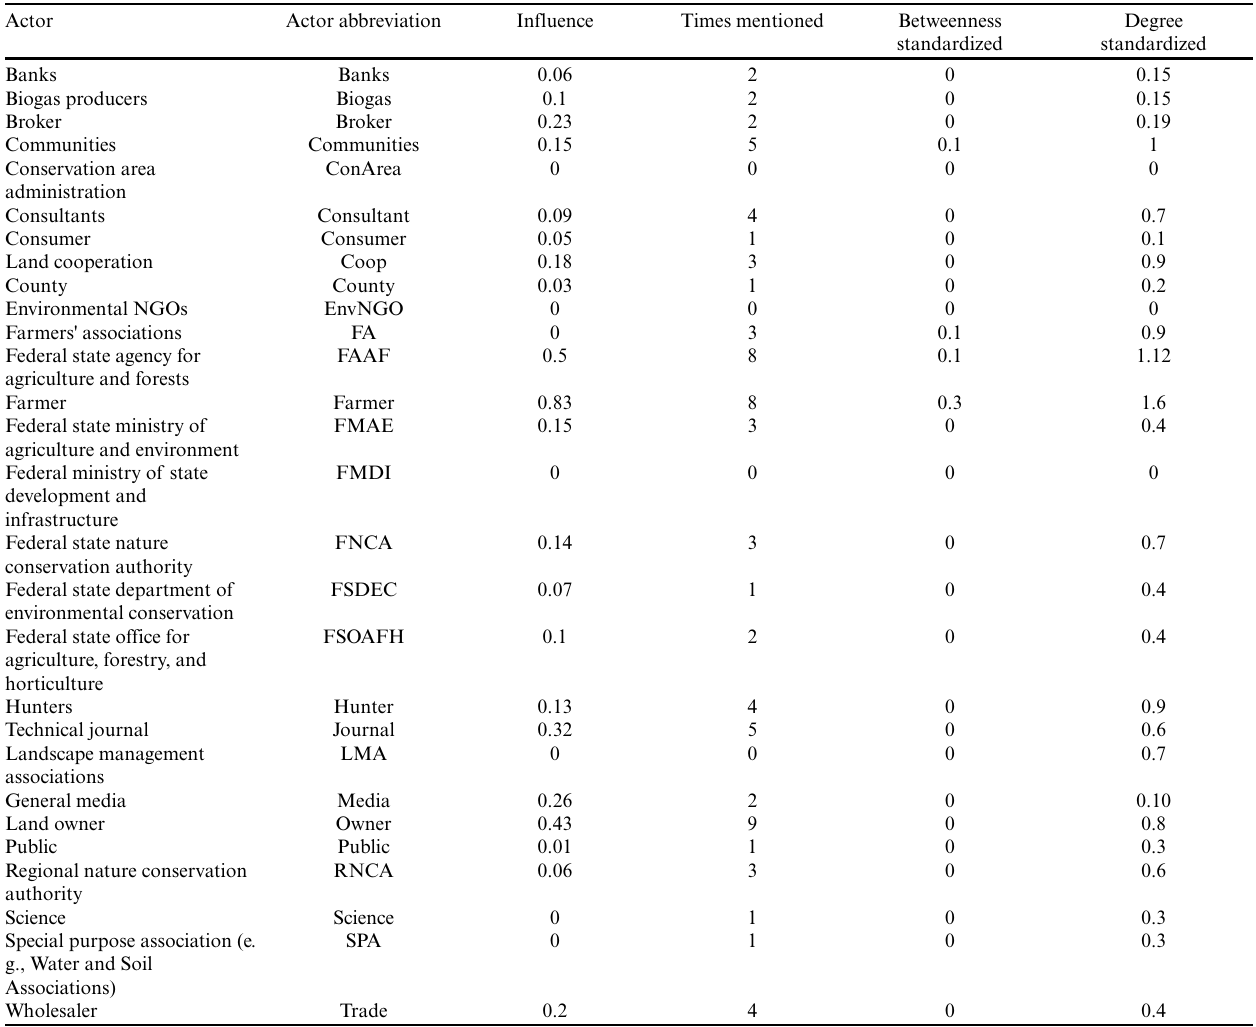
Table 2 . The table presents the results of the interviews at the local level concerning, the average influence of the actors, the number of times the actors were mentioned, standardized betweenness centrality, and standardized degree